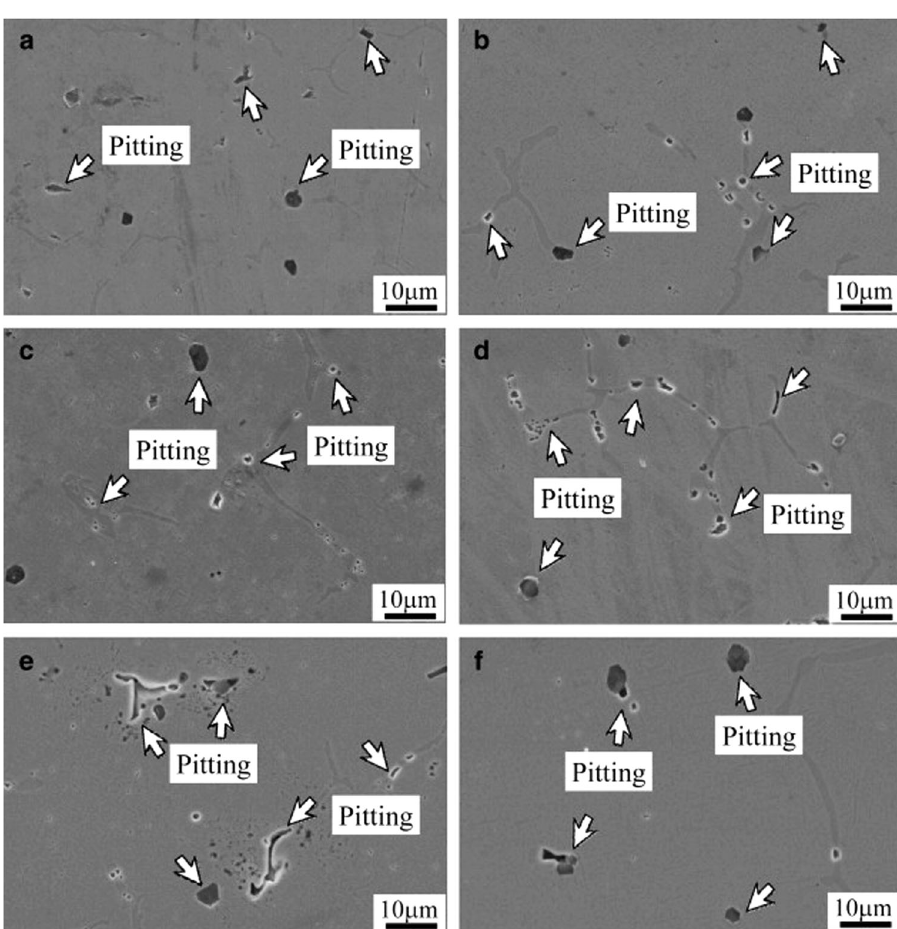
Fig. 15 The surface morphologies of as-cast and aged Al 0.5 CoCrFeNi alloy specimens following immersion in 3.5% NaCl solution at 25 °C: a as-cast, b 350 °C, c 500 °C, d 650 °C, e 800 °C and f 950 °C ( a – f reprinted from ref. 73, with permission from